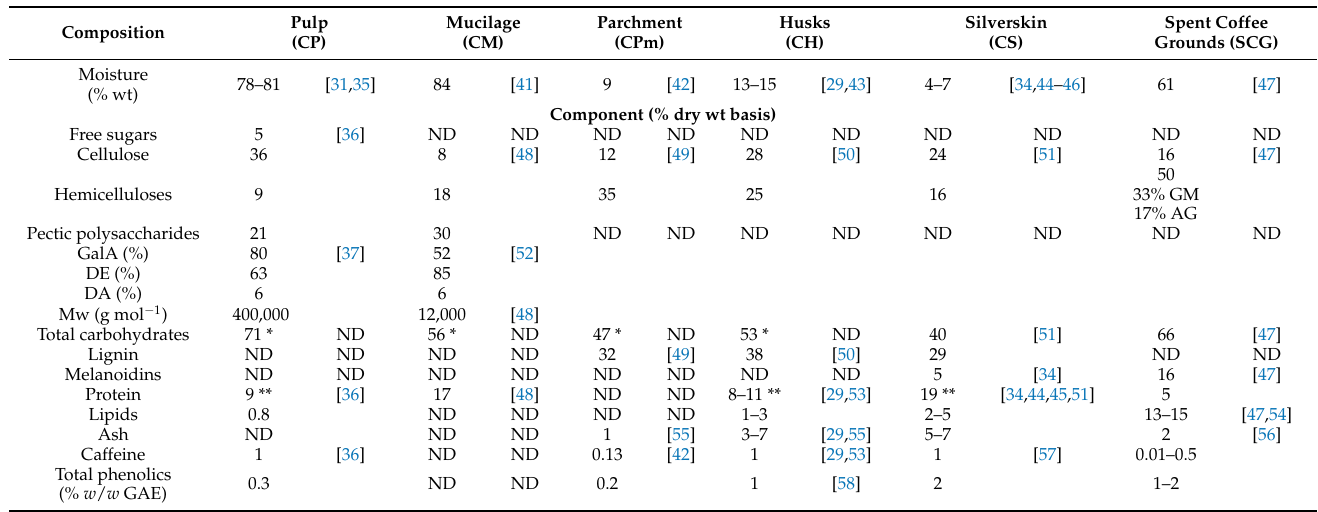
Table 1. Chemical composition of coffee